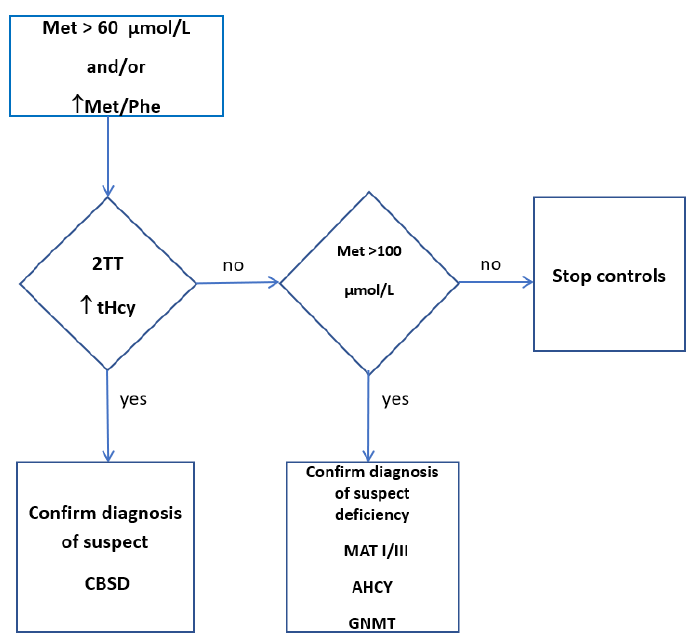
Figure 2. Proposal for a screening flow-chart in patients with hypermethioninemia. Met: Methio- nine. Met/Phe: methionine/phenylalanine. 2TT: second-tier test. Hcy: Homocysteine. MAT I/III: Methionine adenosyltransferase I/III. AHCY: S-adenosylhomocysteine hydrolase. GNMT: glycine N-methyltransferase. CBSD: Cystathione Beta-Synthase Deficiency.